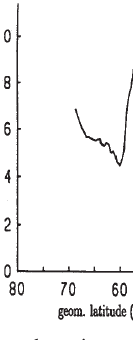
Fig. 9.9. Example for a very sharp trough region enhancement (Leitinger, 1993). Electron content in units of 10 16 m − 2 versus eccentric dipole latitude from NNSS Diff. Doppler, receiving station Uppsala (59.8N, 17.6E). Si- multaneous observations from Lindau/Harz (51.6N, 10.1E) prove that the Uppsala observations are not an arte- fact. Date: 28 November 1980; time: around 1:20 UT.